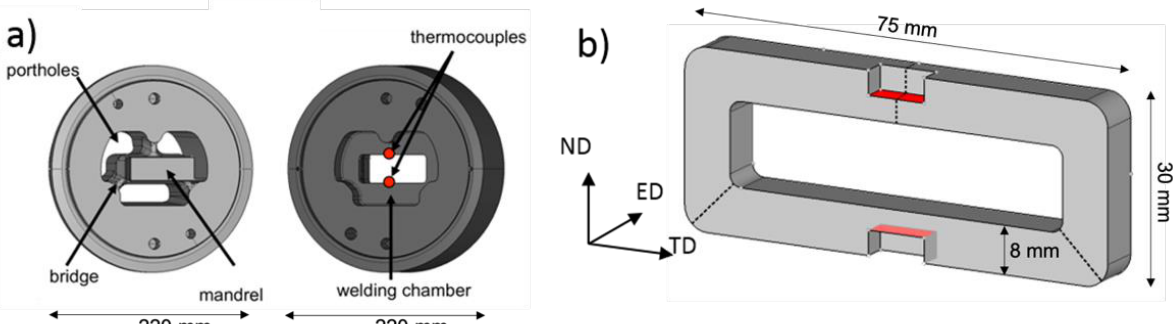
Figure 1. ( a ) Porthole die for the extrusion of hollow magnesium profiles, ( b ) position of the EBSD measurement (red areas) with respect to the profile orientation, ER = 8:1, and weld seam locations represented by dotted lines .